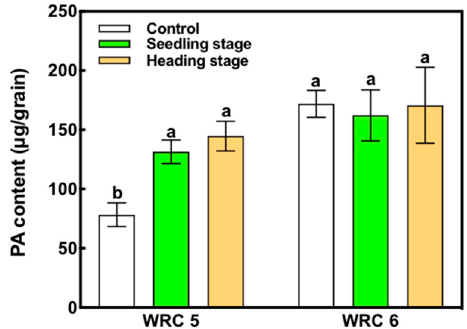
Figure 1. Effect of the time of P fertilizer application on the PA content in WRC 5 and WRC 6. White, green, and orange indicate control, P applied in the seedling stage, and P applied in the heading stage, respectively. Each value represents the mean ± SD of four replicates. Di ff erent letters indicate statistical di ff erences (Tukey’s HSD test, p <